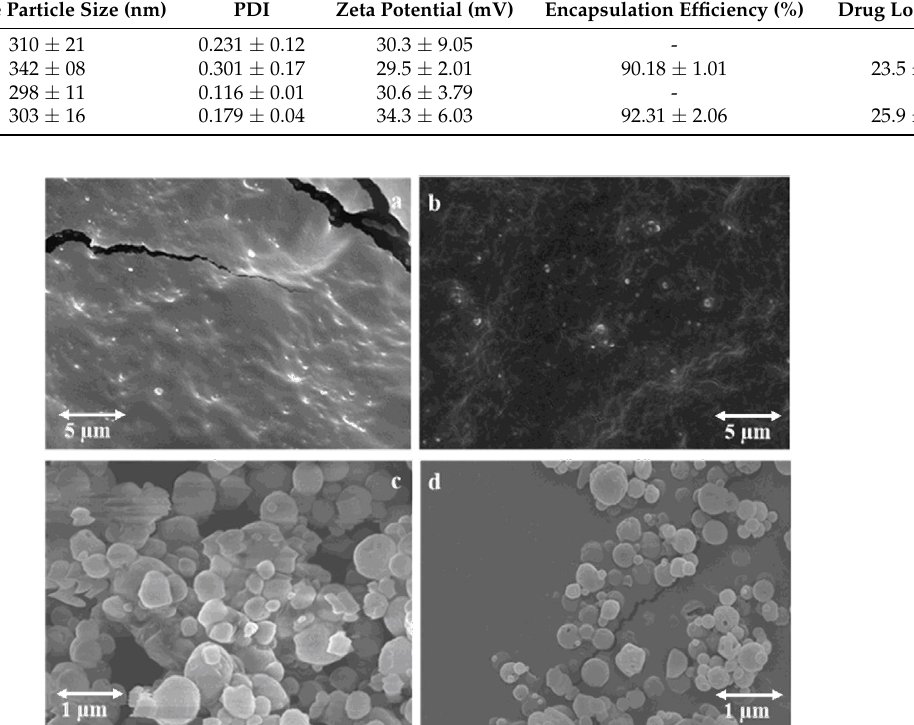
Figure 3. SEM micrographs of INH-CS/HA nanopowder ( a , c ) and INH-MC/HA NPs ( b , d ) were ob- tained separately with the 1 and 5 µm scale